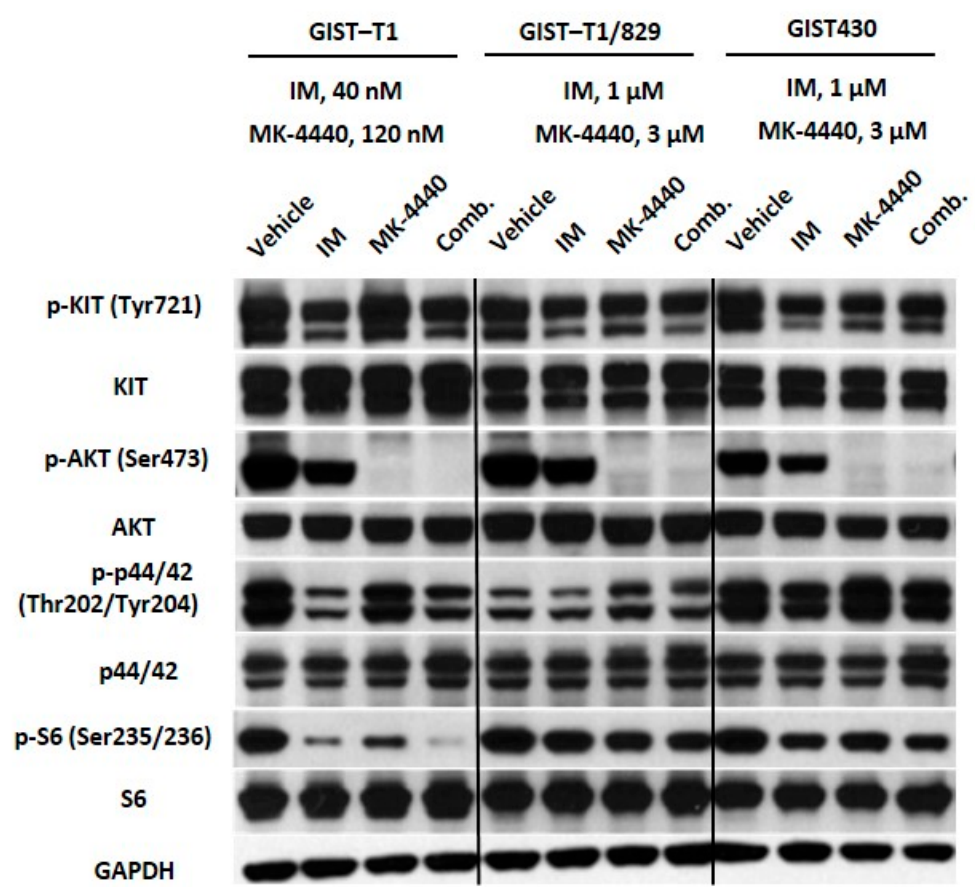
Figure 2. The combination of IM and MK-4440 inhibits constitutive activation of effectors downstream of KIT. Immunoblot assays of WCEs from GIST-T1 treated with 40 nM IM, 120 nM MK-4440 or the combination; and GIST430 and GIST-T1/829 treated with 1 µ M IM, 3 µ M MK-4440, or the combination. All treatments were twenty hours in duration. Equal quantities of WCE from each sample were subjected to immunoblotting with specific antibodies, as indicated. GAPDH served as loading control.